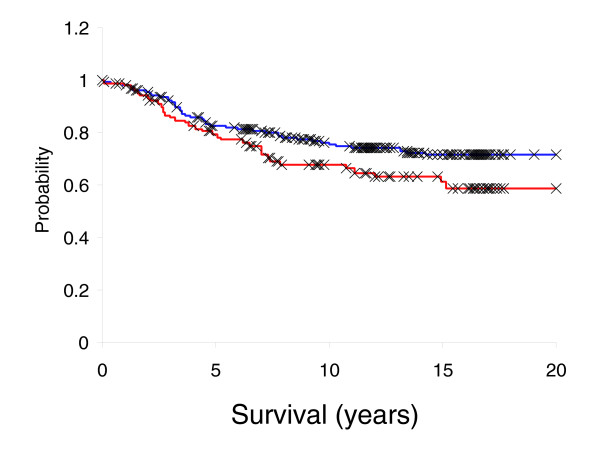
Immunohistochemical staining of STAT1 in a cohort of primary breast cancers: Kaplan-Meier disease-specific survival curve for 353 primary tumors assessed for STAT1. The red curve shows 102 patients bearing tumors with high STAT1 expression whereas the blue curve represents 251 patients with low or absent STAT1 expression. X = censored data.